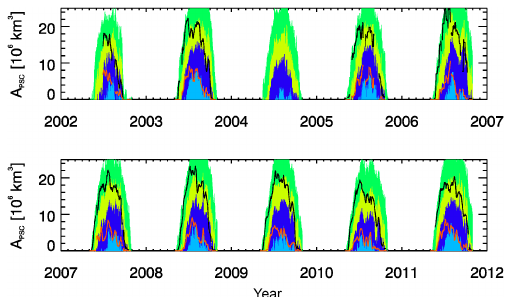
Figure 15. NH interseasonal variation of A PSCmax and A ICEmax based on ERA-Interim and MIPAS (see Fig. 14). In the lower panel, dates of NH volcanic eruptions with stratospheric aerosol burden are superimposed to highlight the link to the artificial A PSC en- hancements in November 2008, 2009, and 2011 and which are not caused by PSCs. Please note that data before 1 November are not considered in the